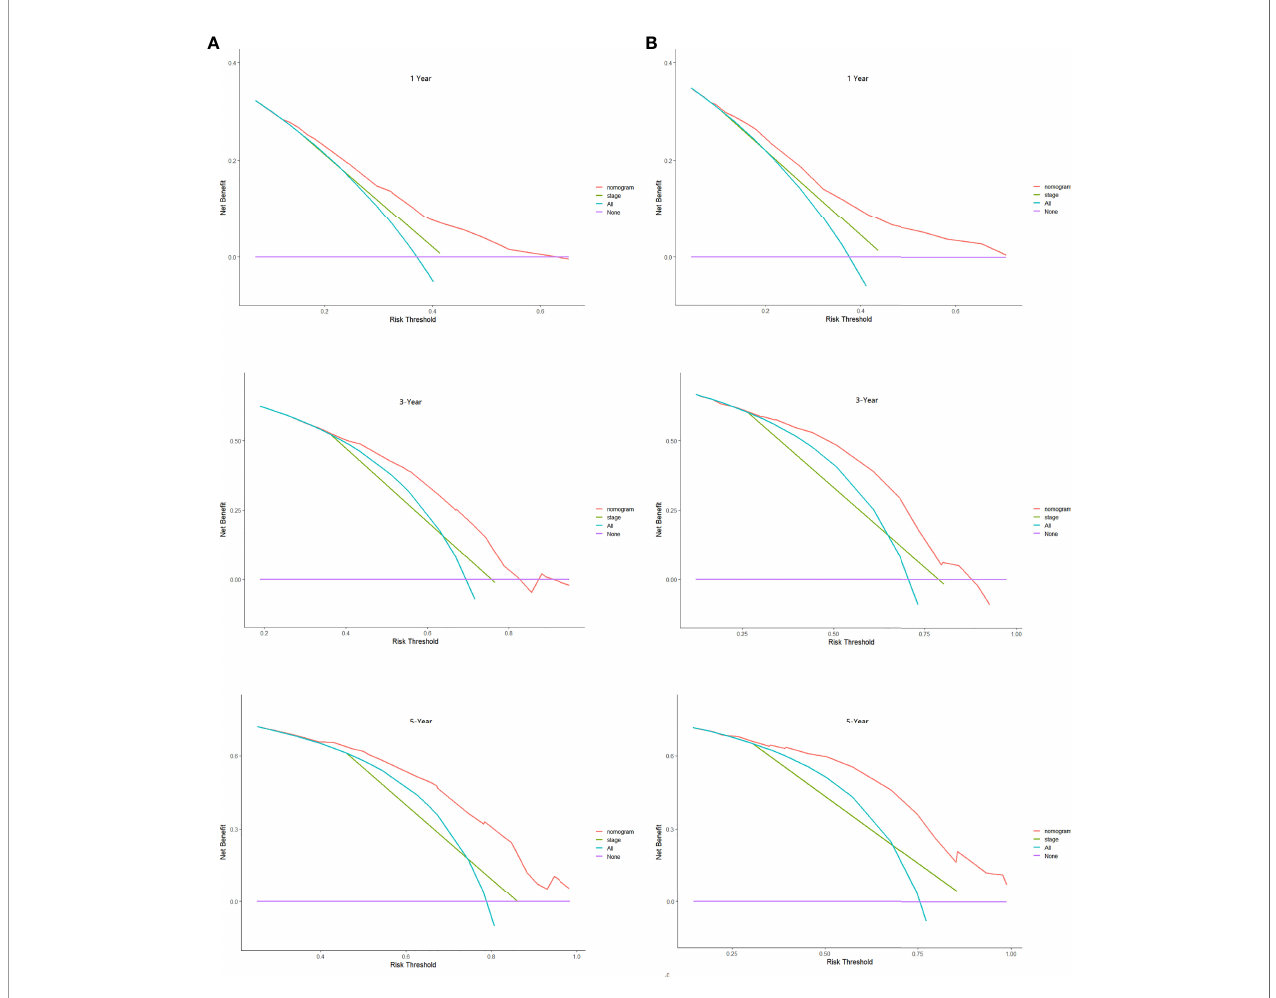
FIGURE 8 | The decision curve analysis of the prognostic nomogram in training (A) and validation sets (B)